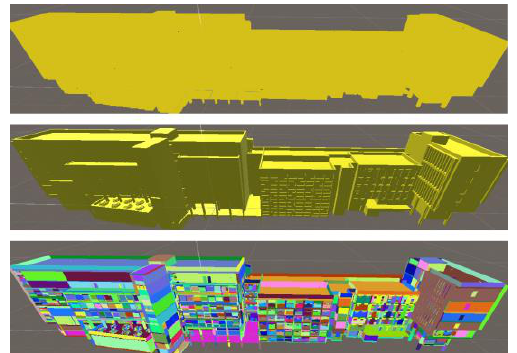
Figure 6 . Voxel visualisation using VFX graph; top image shows voxel visualisation using cubes for each voxel; the middle image shows voxel visualisation using only visible quads; bottom image shows voxels considering each object to which they belong.